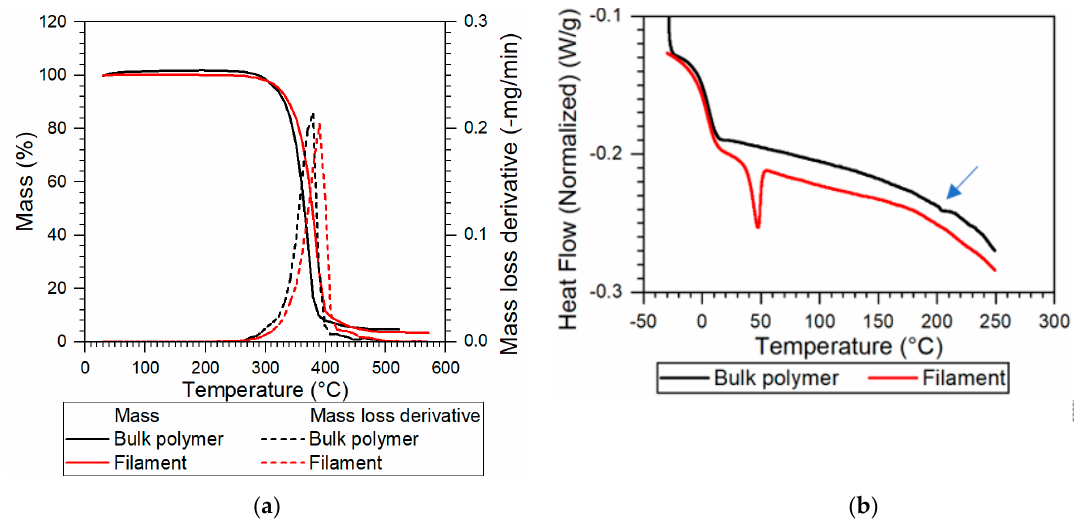
Figure 4. Thermal analysis results of the SH-TPU in the bulk and the filament form. ( a ) TGA at 5 °C/min; ( b ) DSC at 5 °C/min (endo down); the blue arrow indicates the reproducible endothermic peak at near 200 °C.